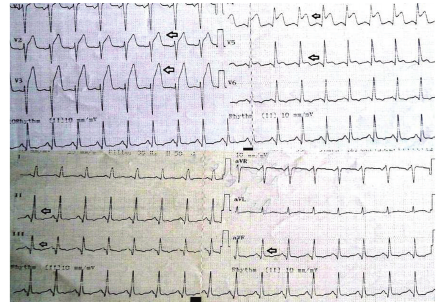
Figure 1: ST segment elevations in precordial leads.